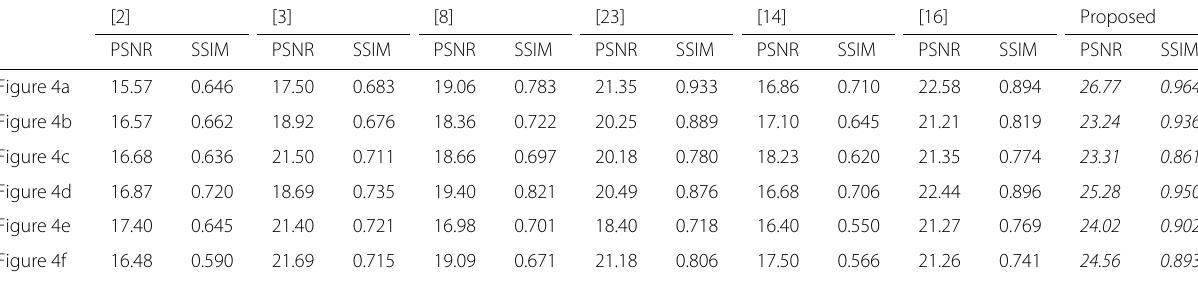
Table 1 Objective performance evaluation using PSNR and SSIM values with σ =